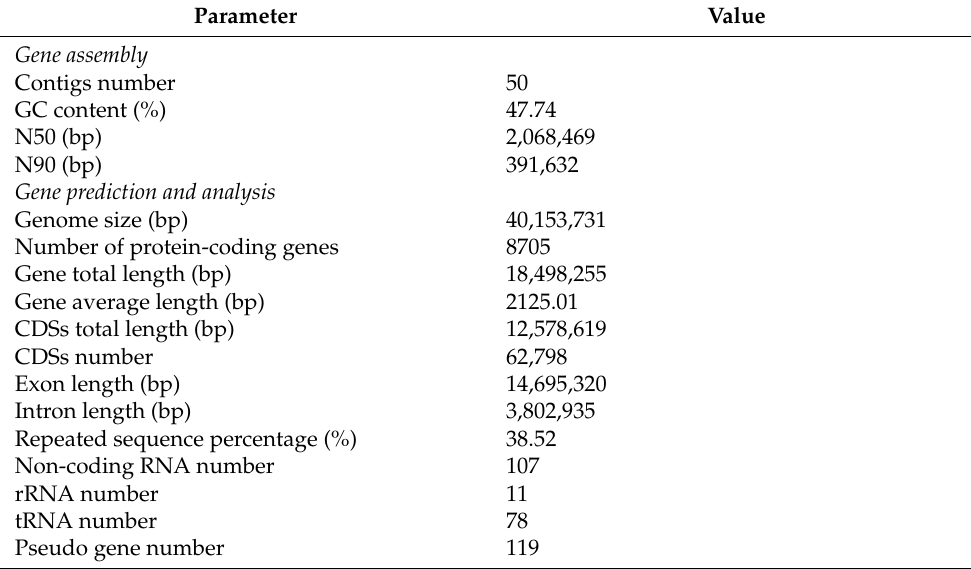
Table 1. The analysis of the gene assembly and genome of G. purpuraceus